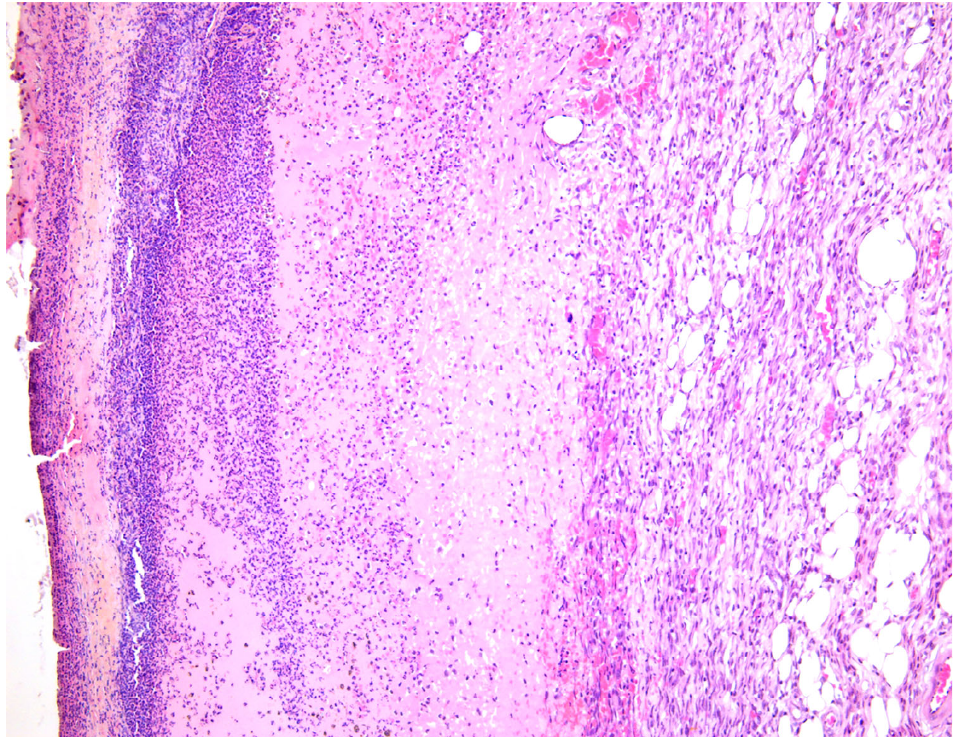
Figure A3. Histology of the wound treated with saline solution at post-operative day 7, hematoxylin and eosin staining, magnification—10×.